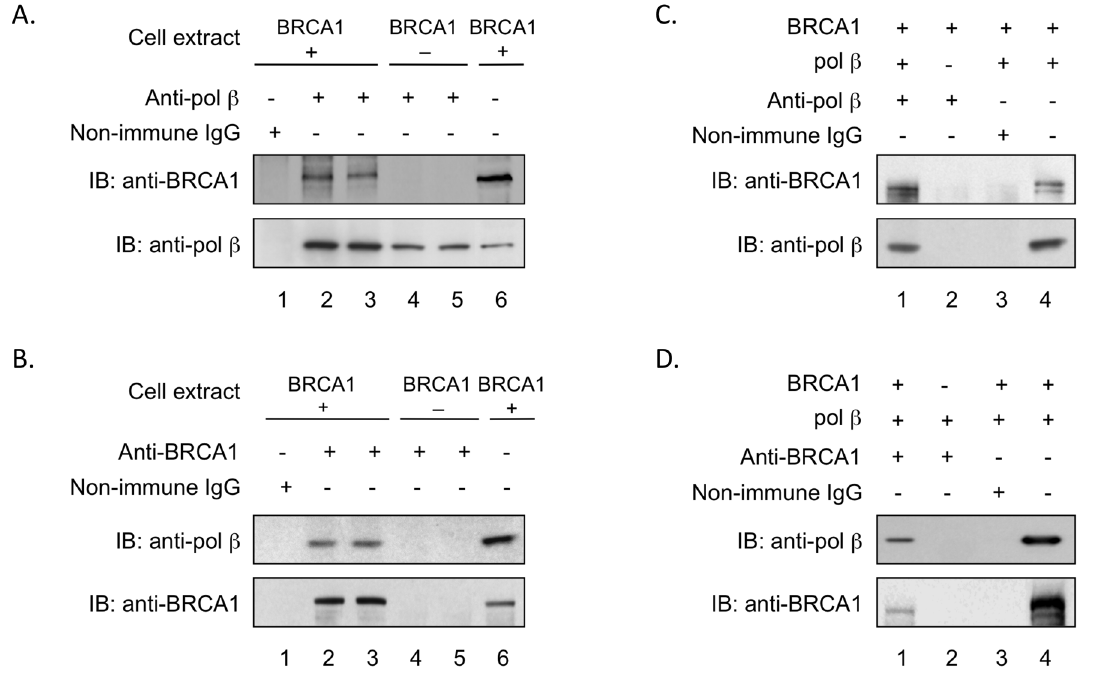
Figure 4. Co-immunoprecipitation analysis for human BRCA1 and pol b interaction. Experiments were conducted as described under ‘‘Materials and Methods’’. Typical results obtained in at least three experiments are shown. Immunoprecipitated proteins were detected by SDS-PAGE and immunoblotting (IB). A. Cell extracts, as indicated, were immunoprecipitated with anti-pol b antibody (lanes 2–5) or non-immune IgG (lane 1). Lanes 2–3 and 4–5 are duplicates. Lane 6 corresponds to immunoblotting of the BRCA1-complemented extract, used here as a source of markers for BRCA1 and pol b . B, Cell extracts as indicated were immunoprecipitated with anti-BRCA1 antibody (lanes 2–5) or non-immune IgG (lane 1). Lanes 2–3 and 4–5 are duplicates, and lane 6 was as described in panel A. C. Purified human BRCA1 and pol b proteins were mixed and immunoprecipitated with anti-pol b antibody (lane 1) or non-immune IgG (lane 3). Pol b was omitted in lane 2, and lane 4 corresponds to the purified proteins used as markers. D. The same purified protein mixture as in panel C, except that immunoprecipitation was with anti-BRCA1 antibody (lane 1) or non-immune IgG (lane 3). BRCA1 was omitted in lane 2.